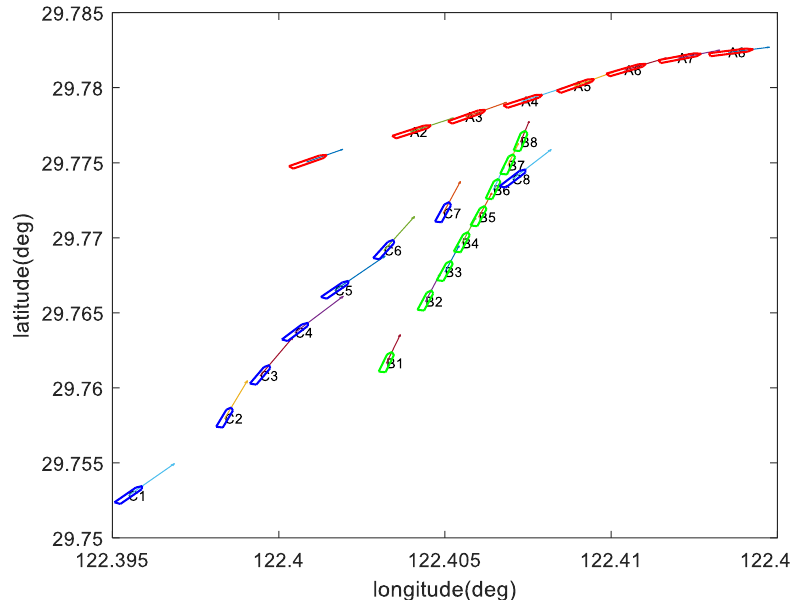
Figure 12. Schematic diagram of multi-ship encounter process.